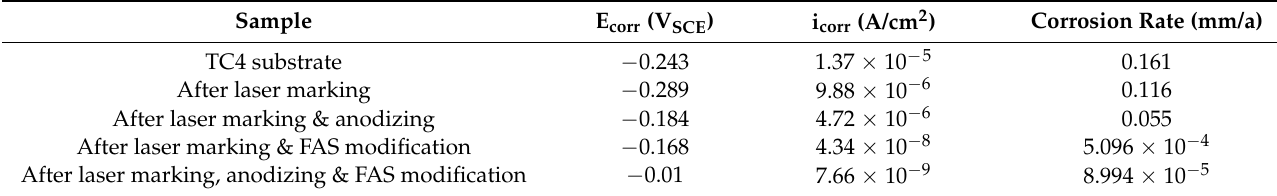
Figure 6. Tafel polarization curves recorded on the samples at different processing stages, tested in 3.5 wt% NaCl solution. Table 1. Tafel polarization parameters of the samples at different processing